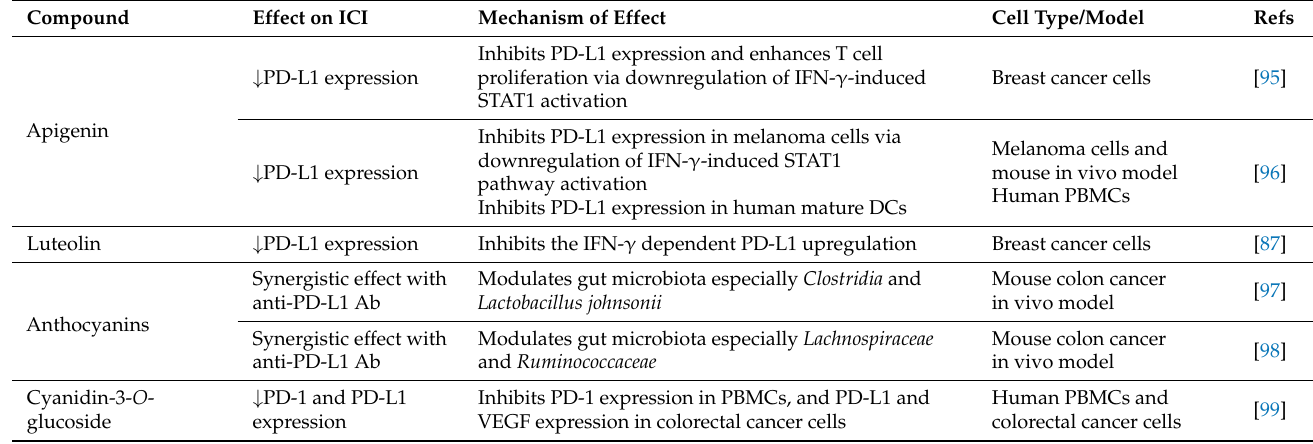
Figure 3. Classification of phytochemicals modulating activity of ICI according to chemical structures. Listed compounds are classified into the families of flavonoids, non-flavonoids, terpenes, and others. Flavonoids include EGCG, apigenin, luteolin, silymarin, anthocyanins, quercetin, C3G, icaritin, baicalein, and hesperidin. Non-flavonoids include curcumin, resveratrol, piceatannol, polydatin, CAPE, gallic acid, and emodin. Terpenes include lycopene, β -elemene, fraxinellone, cannabidiol, cryptotanshinone, triptolide, ginsenoside Rg3, ginsenoside Rk1, ginsenoside Rh2, platycodin D, diosgenin, and panaxadiol. Others include sulforaphane and camptothecin. EGCG: epigallocatechin gallate; C3G: cyanidin 3- O -glucoside; CAPE: caffeic acid phenethyl ester. Table 1. List of polyphenolic compounds (flavonoids and non-flavonoids) and their effects with mechanisms on immune checkpoints